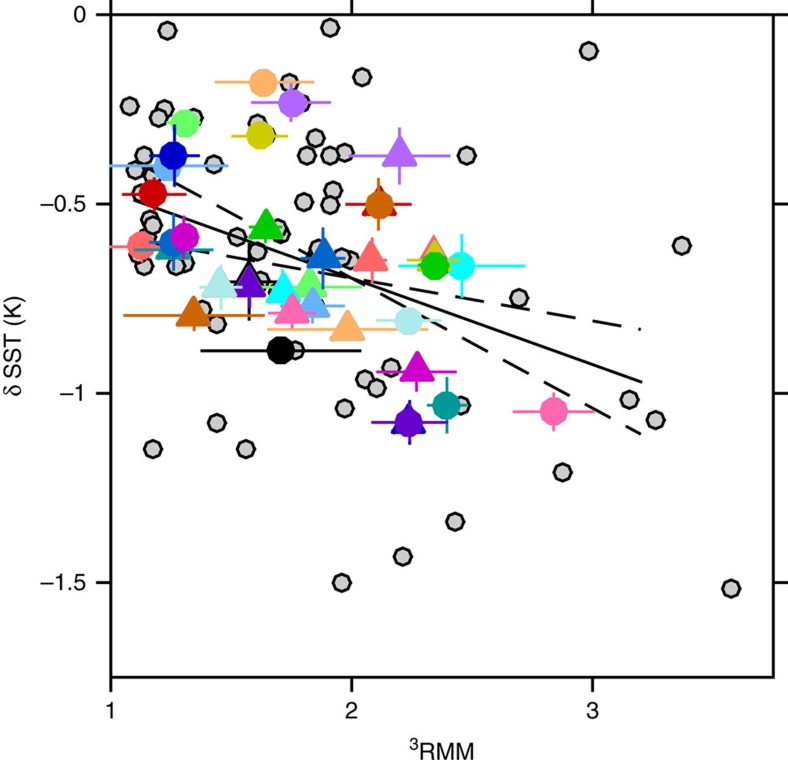
Net surface cooling of 84 MJO pulses relative to 3RMM.Data represent pulses identified using reanalysis data products between 1980 and 2013, as described in the text. Of these 84 pulses (grey circles), 18 pulse pairs separated by <55 days are plotted with matching colours, each colour representing a pair of pulses. The first of the pair are denoted by circles, the second by triangles. Confidence limits are defined in the Methods. The pulse pair data are significantly and negatively correlated with r=−0.49 [−0.71, −0.20], P value=0.0022. The solid black line represents the regression δSST=−0.23 × 3RMM−0.2. The dashed black lines represent 95% confidence limits on the slope of the regression. Correlations, slopes and P values are not substantially different between the 84 parent pulses and the 36 paired pulses.